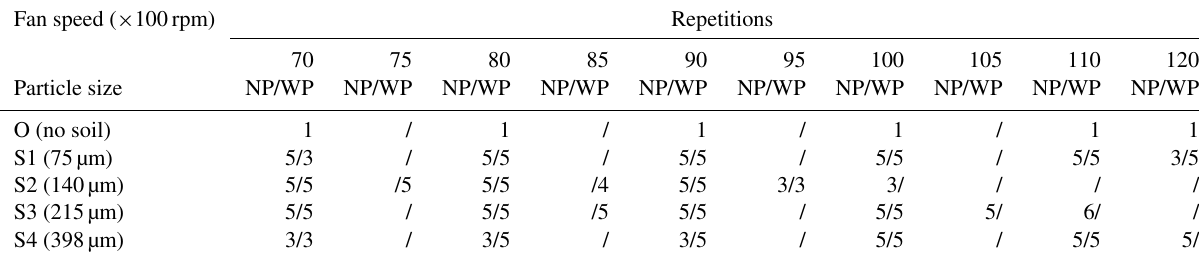
by the Irwin sensor and φ (cid:15) is calculated using Eq. (3) with ζ = 0 for the NP70_O run and ζ = − 2 for the WP70_O run. For comparison, the ABL velocity power spectra, denoted as P ABL , for three different stabilities ζ = 0, − 0 . 8 and − 2 are plotted. The empirical form given by Kaimal et al. (1972),